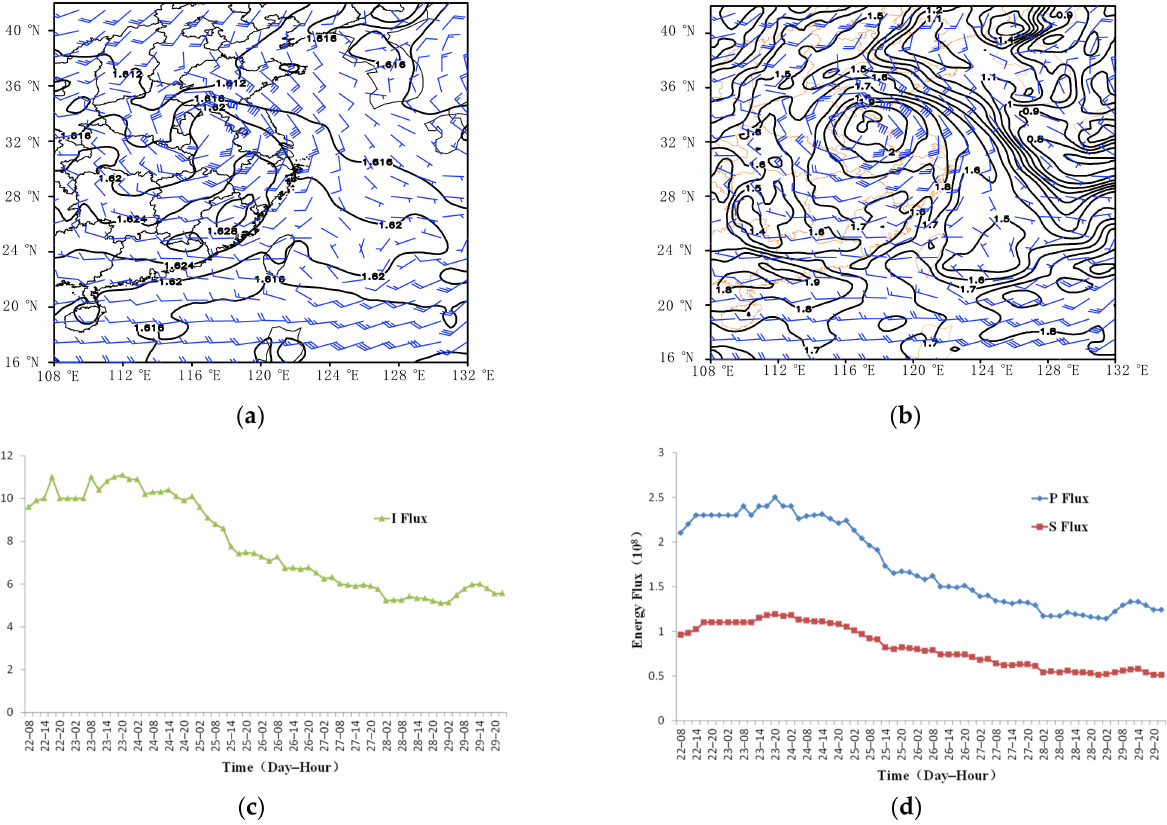
Figure 8. Whole layer atmospheric ( a ) internal energy (unit: 10 7 J m − 2 ), ( b ) latent heat energy (unit: 10 6 J m − 2 ) at 1400 BT on July 28, 2021, and time evolution of ( c ) internal energy flux, ( d ) potential and latent heat energy flux (unit: 10 8 J m − 1 s − 1 ) of the TC’s